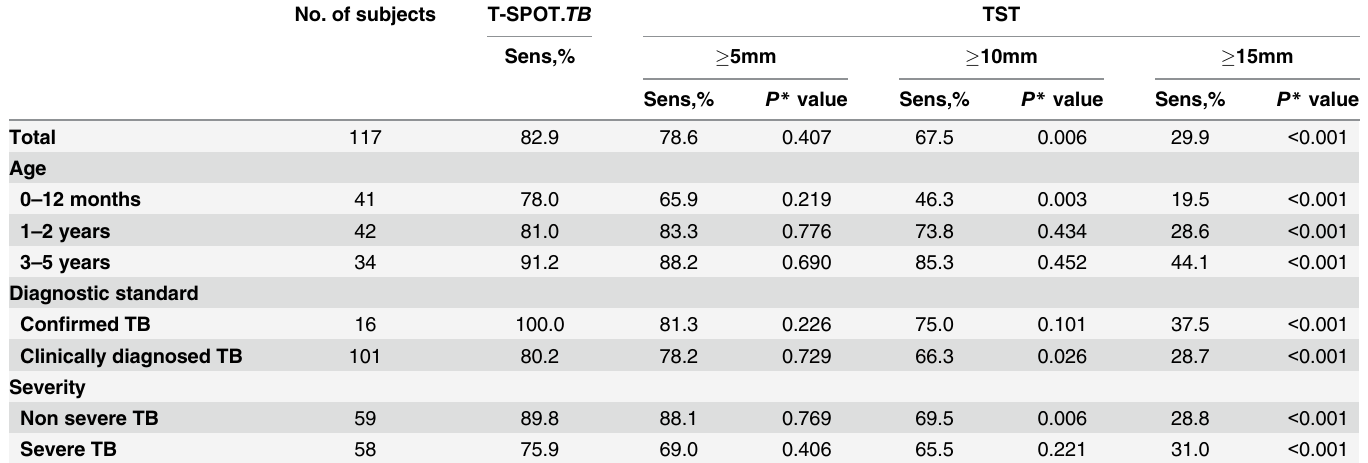
Table 2. Sensitivity of T-SPOT.TB and TST tests in children with confirmed and clinically diagnosed tuberculosis. No. of subjects